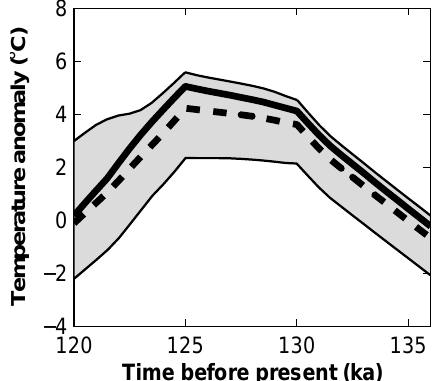
Fig. 7. LIG surface temperature anomaly (relative to pre-industrial period) evolution, averaged over the Glimmer model domain for the valid simulations. Included is the change in temperature due to a lapse rate correction as a result of changing elevation as the ice sheet changes in response to the climate forcing. The solid back line represents the accepted simulation with the highest skill-score for the modern-day GrIS. The dashed black line represents the average for all accepted